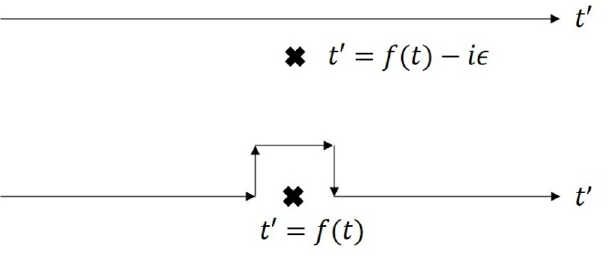
Figure 11 . The choice of contour about t 0 = f ( t ) in contrast to i (cid:15) prescription. For our example, we have f ( t ) = t